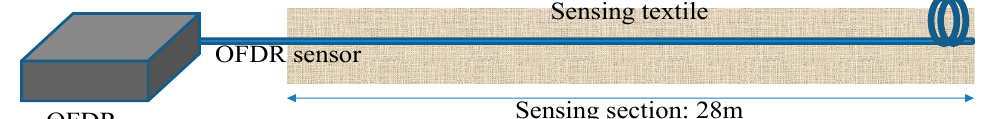
Figure 3. OFDR sensing textile schematic.